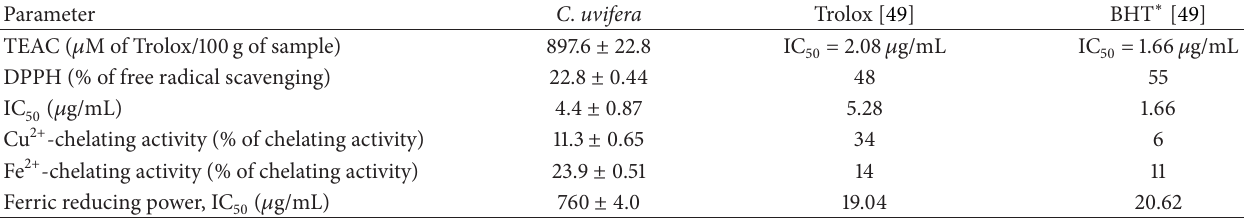
Table 3: Antioxidant properties of C. uvifera fruit pulp compared with standard antioxidants. Parameter